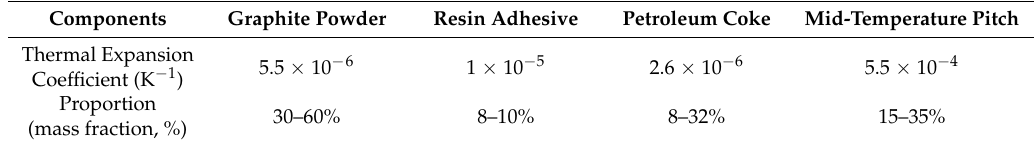
Table 1. Material composition proportions and the thermal expansion coefficients of